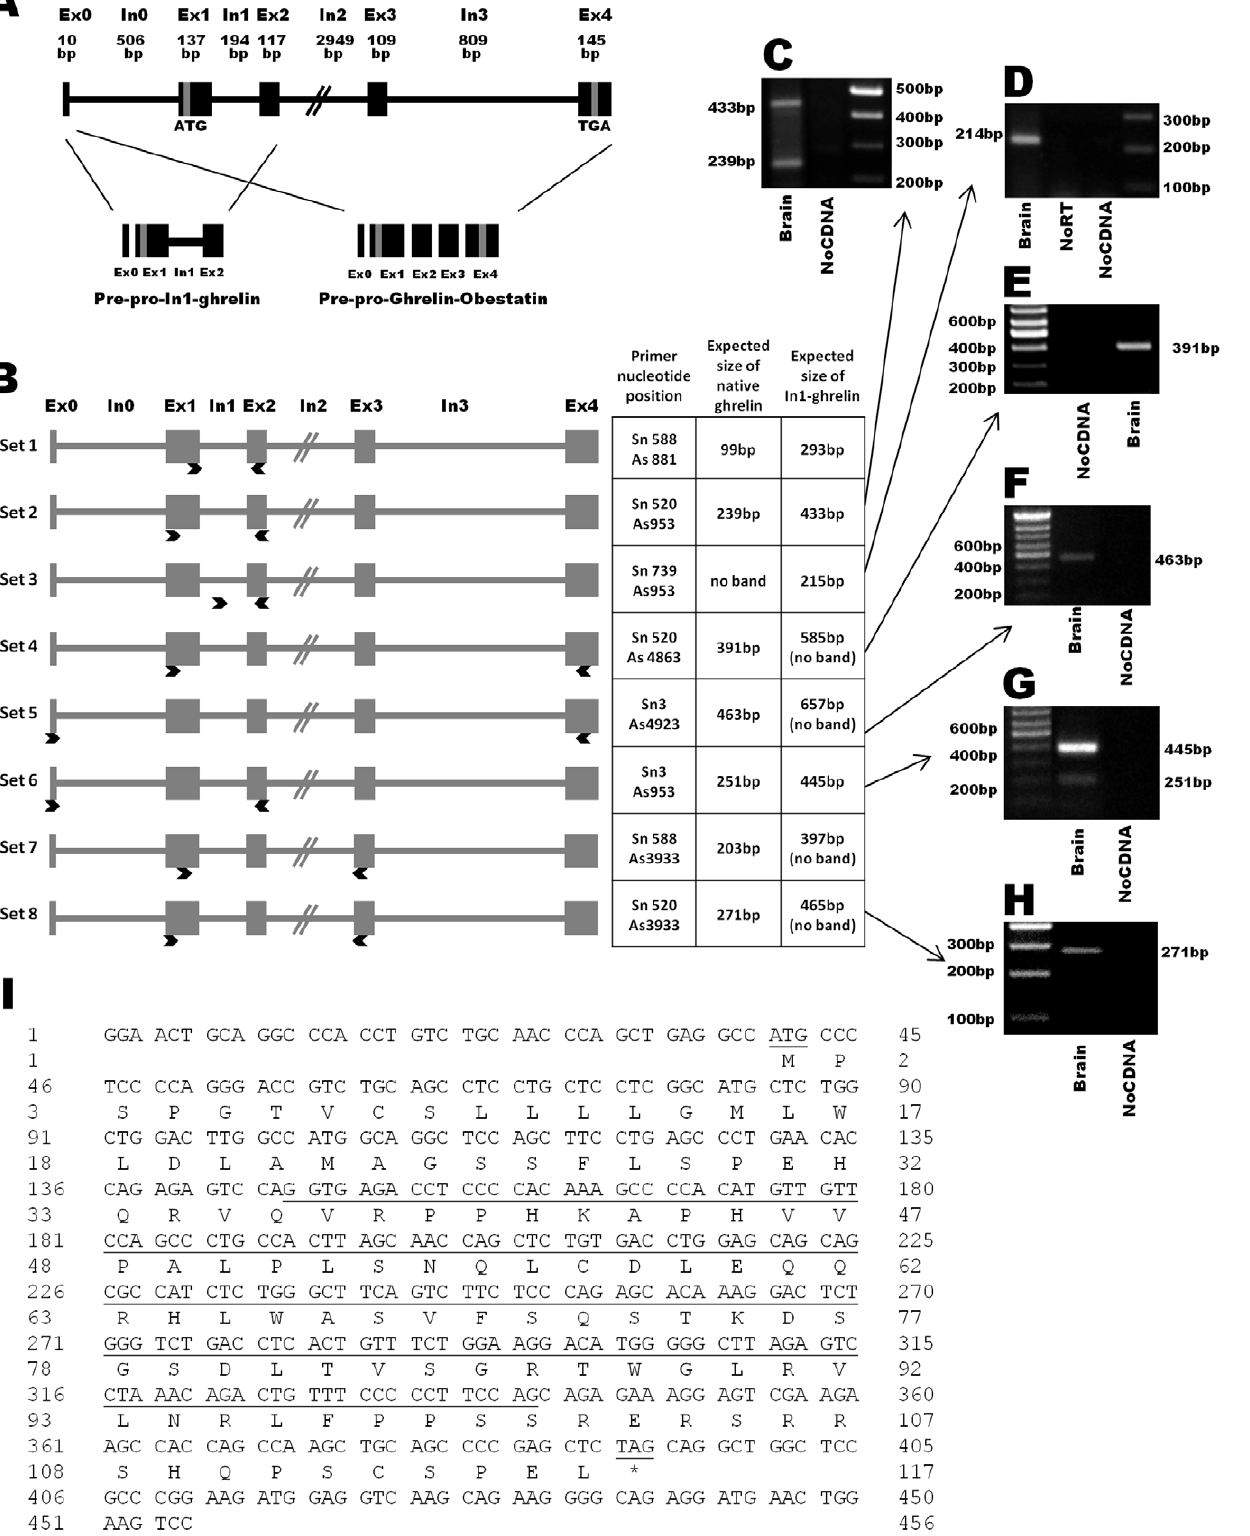
Figure 1. Schematic representation of the human In1-ghrelin variant. (A) Classical organization of human ghrelin/obestatin gene consisting of 5 exons (Ex0–4) and 4 introns (In0–3). Structure of prepro-ghrelin/obestatin and prepro-In1-ghrelin mRNA precursors is also indicated. (B) Schematic diagram showing the primer position (indicated with arrows) used to detect, clone and/or quantitatively amplify the human In1-ghrelin. Exons are represented as boxes and introns as lines. (C–H) PCR products obtained using the previously presented set of primers using brain tissues as